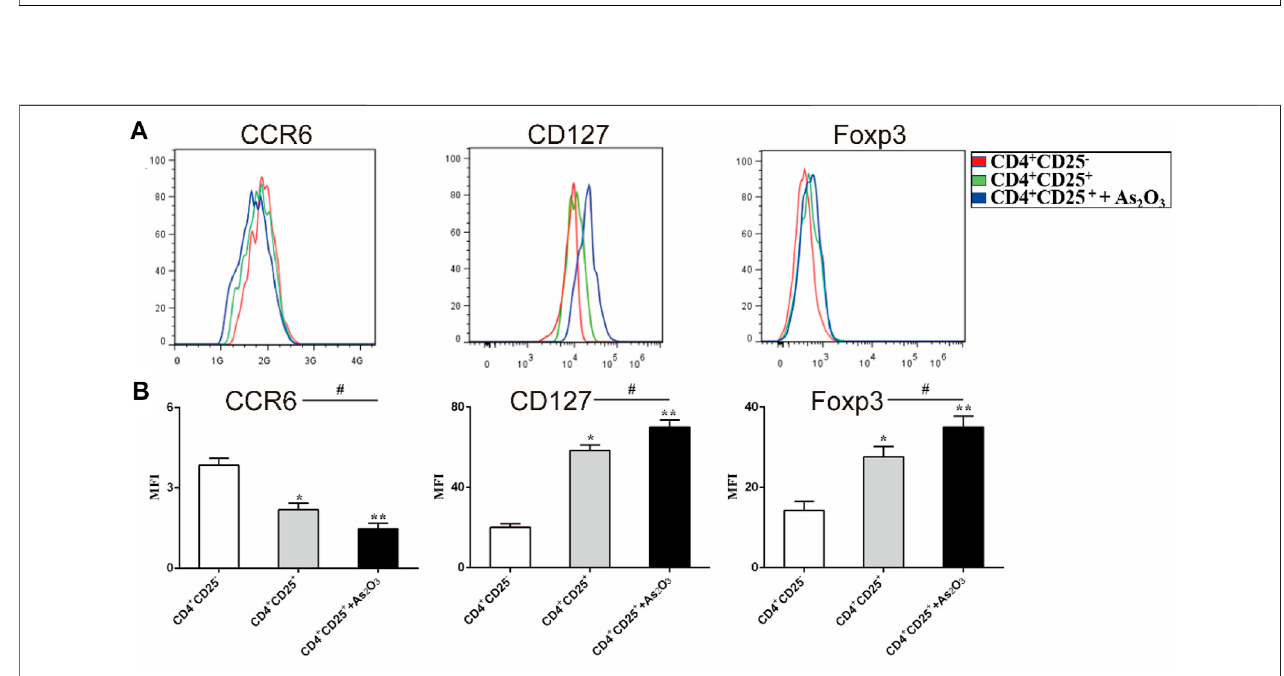
FIGURE 5 | As 2 O 3 affect phenotype of CD4 + CD25 + Treg cells. (A) Histogram represent that surface expression of CCR6, CD127, and intracellular expression of Foxp3 were measured in CD4 + CD25 − T cells, CD4 + CD25 + Treg cells and coculture in the presence or absence of As 2 O 3 . (C) The expression levels of the surface and intracellular markers were quanti fi ed as mean fl uorescence intensity (MFI). The statistical analysis was performed using one-way ANOVA. Data are represented as the mean ± SEM in six independent experiments. # p < 0.05, ## p < 0.01 vs. nontreatment cells; * p < 0.05, ** p < 0.01 vs. CD4 + CD25 − T cells from treatment-naïve RA